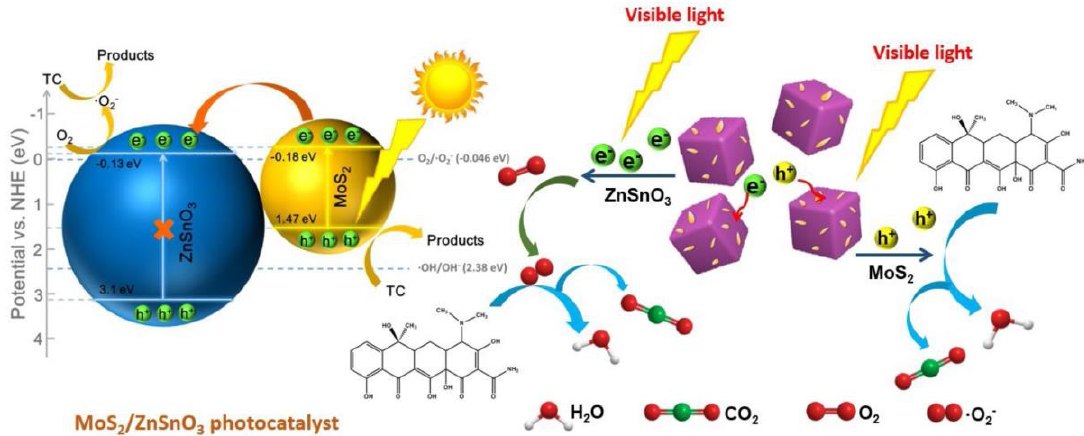
Figure 11. Photocatalytic mechanism of MoS 2 /ZnSnO 3 composite for degradation of tetracycline under visible light irradiation [97].